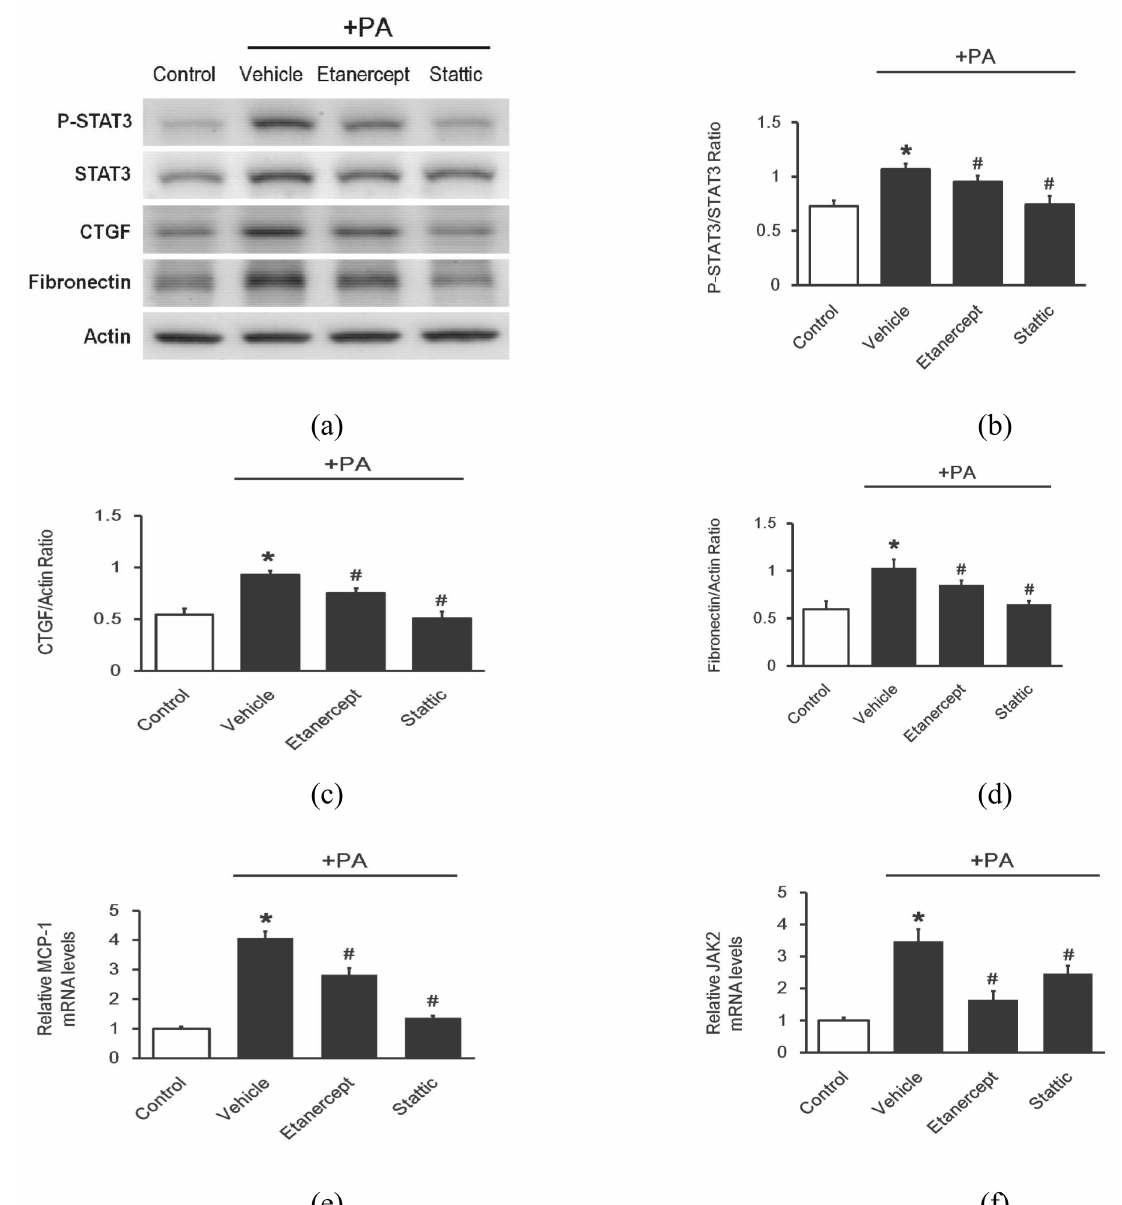
Figure 4. Effects of etanercept on the fibrosis-related gene expression in H9c2 cells stimulated with palmitate (PA). The cells incubated with palmitate (250 µ M) for 48 h were used as the model to mimic the HFD-fed rats. Then, etanercept (50 µ M) or Stattic (1 µ M) was added at 1 h after palmitate stimulation. Western blots of each protein in the H9c2 cells including the non-treated control group (Control), the palmitate-stimulated cells shown as line including the group with vehicle (Vehicle), etanercept group (Etanercept), and Stattic group (Stattic), were compared; p-STAT3, STAT3, CTGF, and fibronectin were measured. Representative blots are presented ( a ); and the quantification of each signal including STAT3 activation (p-STAT3/STAT3) ( b ), CTGF ( c ), and fibronectin ( d ) relative to the internal control was performed for comparison. The mRNA levels of MCP-1 ( e ) and JAK2 ( f ) were also measured using real-time qPCR. The results are shown as the mean ± standard deviation ( n = 4 per group). * p < 0.05 compared with the control group and # p < 0.05 compared with the vehicle-treated group, two-way ANOVA, followed by Bonferroni test. p-STAT3, phosphorylated signal transducer and activator of transcription 3; CTGF, connective tissue growth factor; MCP-1, monocyte chemoattractant protein-1; JAK2, Janus kinase 2; qPCR, quantitative polymerase chain